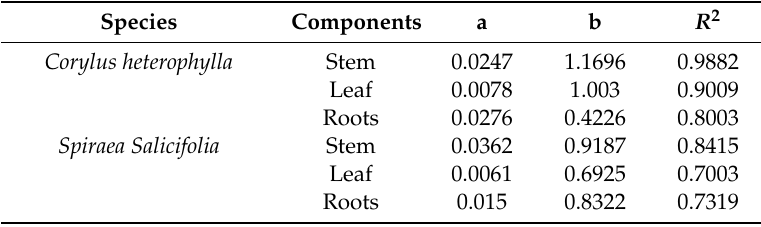
Table A2. Equations for calculating Stem, Leaf and Roots biomass (kg) of dominant shrub species used in this study (N = 15). Equations follow the form W = a × (D 02 · H) b , where a and b are the equation parameters, D 0 and H are basal diameter (cm), and height (m) of a shrub, respectively, W is the biomass of the respective tree component